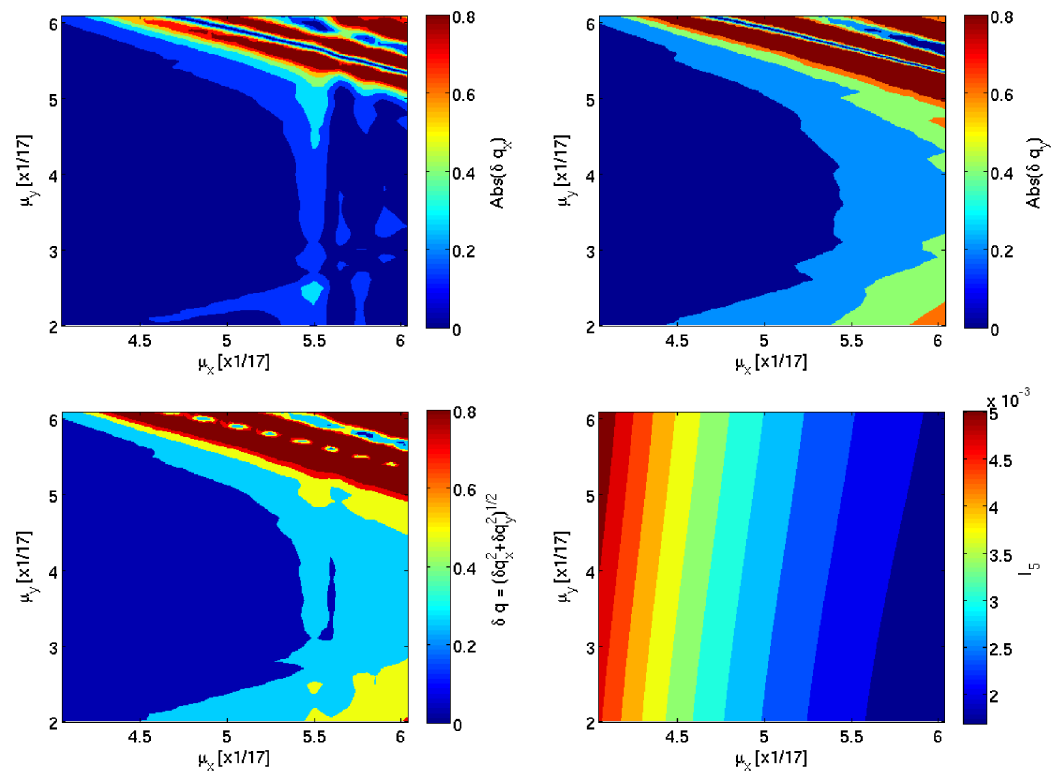
FIG. 11. Top: Parametrization of the horizontal (top, left) and vertical (top, right) amplitude dependent tune shift, with the horizontal and vertical phase advances of the TME cell. Bottom: Parametrization of the square root of the quadratic sum of the horizontal and vertical amplitude dependent tune shifts (left) and of the fifth radiation integral (right), with the horizontal and vertical phase advances of the TME